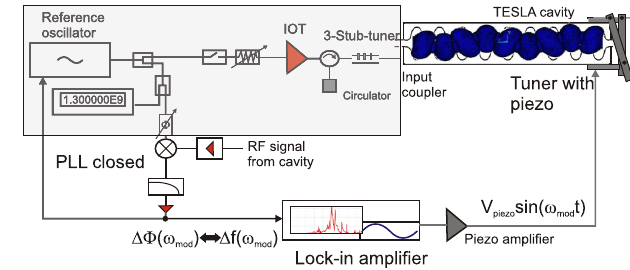
FIG. 10. (Color) Measurement setup to obtain the transfer func- tion between piezo excitation and cavity detuning response.